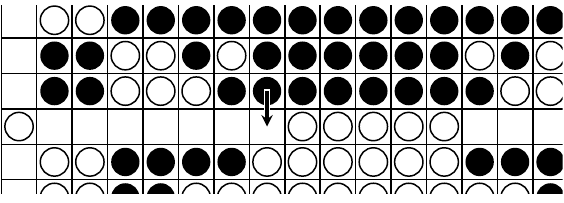
Figure 85. Black comes